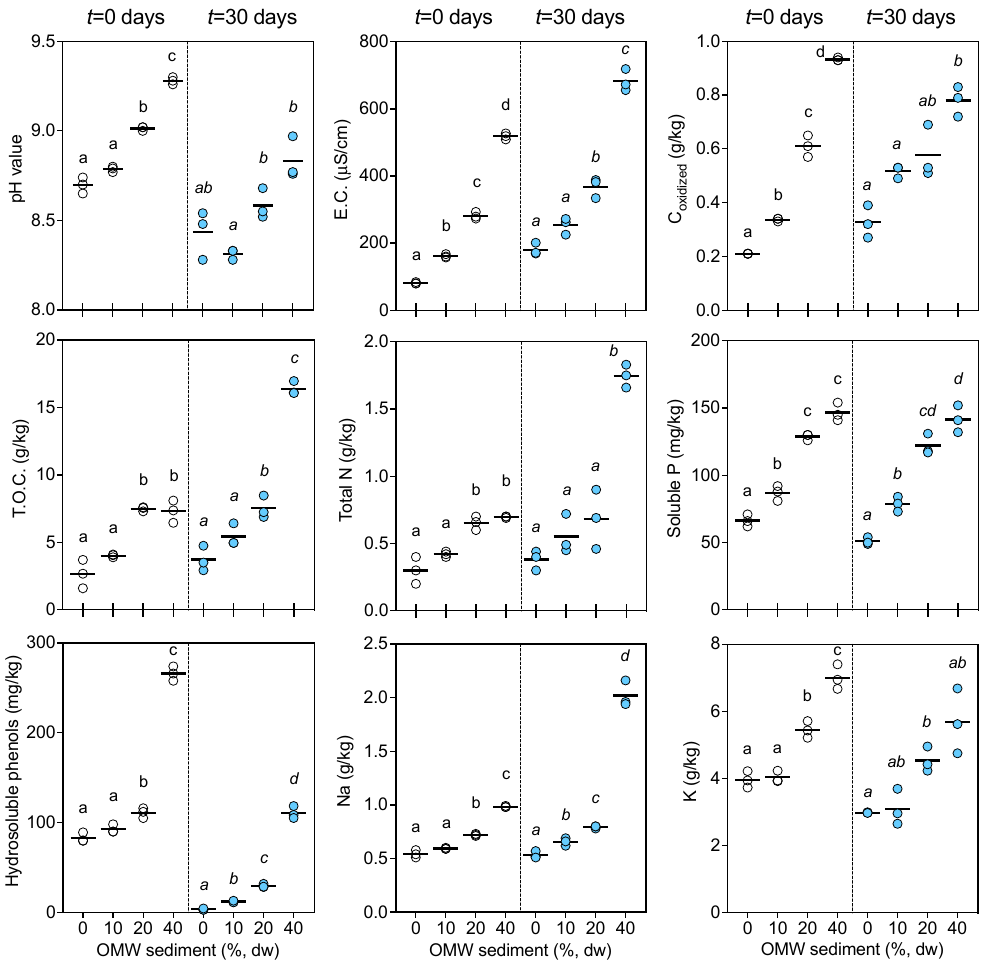
Figure 6. Variation of physicochemical parameters in olive mill waste (OMW)-amended soils during 30-d incubation in the presence of earthworms ( Lumbricus terrestris ). Different letters denote significant differences between treatments within a sampling time (normal fonts for t = 0 d, and cursive fonts for t = 30 d), ANOVA with Welch’s homogeneity correction ( p < 0.05). Horizontal solid lines in the univariate scatterplots are the mean values.